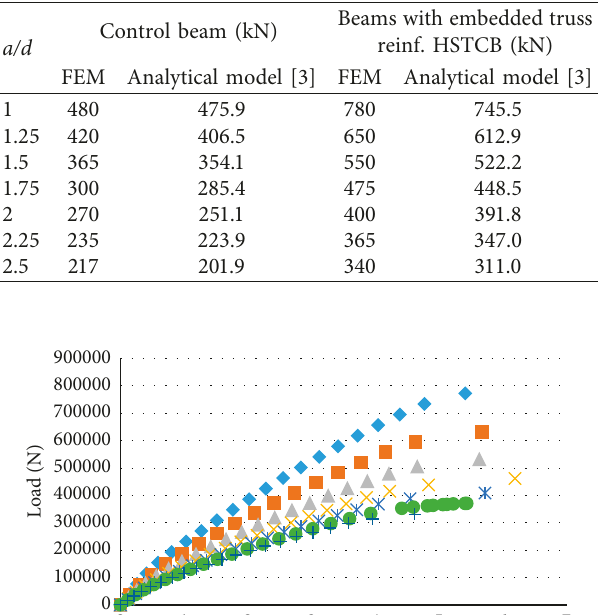
Table 2: Comparison between the calculated and FE load-carrying capacity of RC beams.